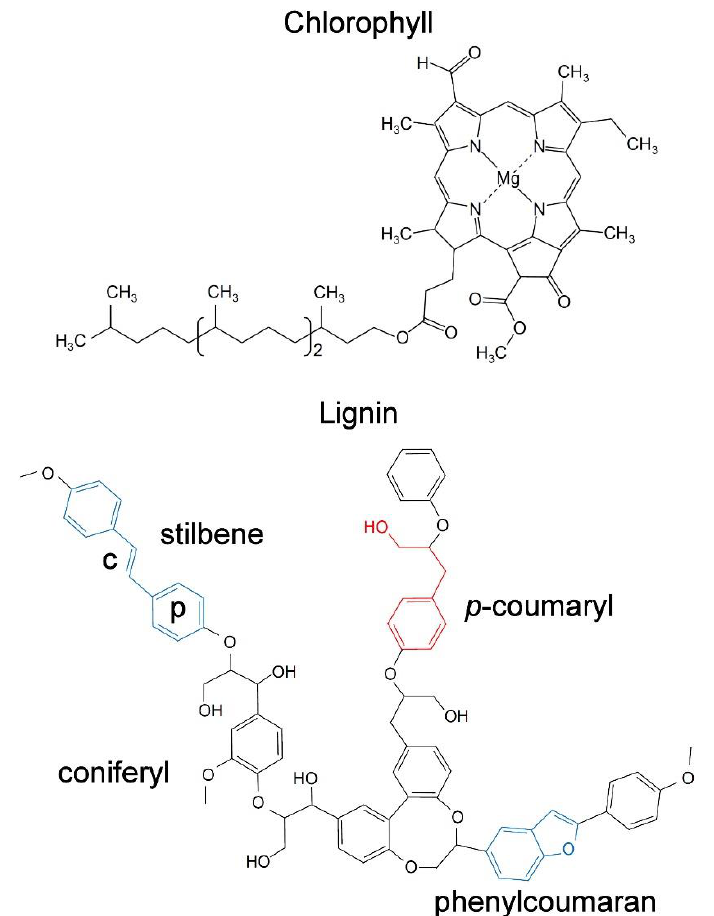
Figure 3. The molecular structure of chlorophyll and lignin to illustrate typical fluorescent structures. Chlorophyll contains a large complex porphyrin ring structure accounting for most of its fluorescence. However, chlorophyll molecules within chloroplasts occur in ordered arrays called photosystems which are also likely to influence the fluorescence. Lignin forms a large complex molecule—only a fraction of which is shown here. Structural components that may contribute to the overall fluorescence of lignin are highlighted including phenolic rings (p) and conjugated bonds (c). These types of structures are characteristic of organic fluorophores.